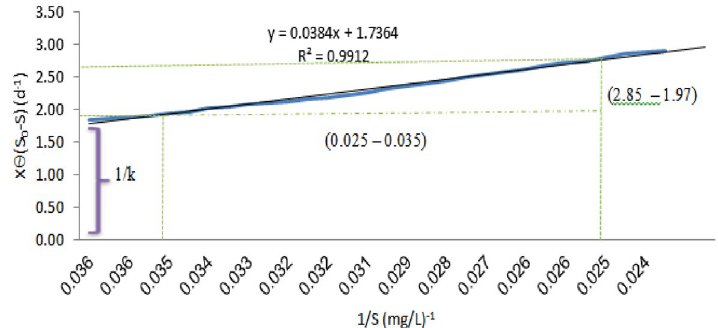
Figure 4. Estimated the k and K s in ASM 2.